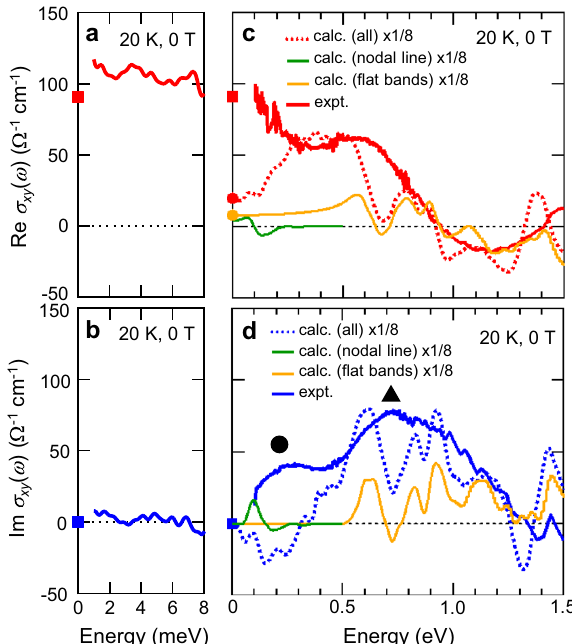
Fig. 3 Terahertz and infrared Hall conductivity spectra. The real a and imaginary b parts of the terahertz Hall conductivity spectra ω ) at 20 K. c The real part of the experimental (red solid curve) σ xy ( and calculated (red dotted curve) optical Hall conductivity spectra ω ) in the infrared region. d The imaginary part of the σ xy ( experimental (blue solid curve) and calculated (blue dotted curve) optical Hall conductivity spectra σ xy ( ω ) in the infrared region. The green solid curves display the calculated σ xy ( ω ) when considering only six bands composing the nodal lines (red lines in Fig. 4c). The orange solid curves show the calculated σ xy ( ω ) when considering the optical transition from the bands located at − 0.8 – − 0.5 eV which include the fl at bands around − 0.65 eV (orange regions in Fig. 4b, c). All the calculated spectra are multiplied by a factor of 1/8 for comparison. The red and blue squares at zero energy in (a-d) represents the dc Hall conductivities at 0 T acquired from the transport